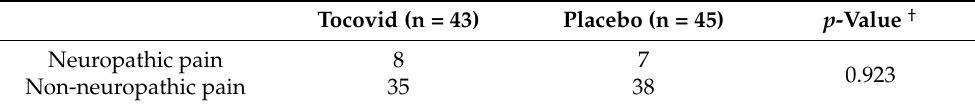
Table 6. Neuropathic Pain Questionnaire (NPQ) scores at